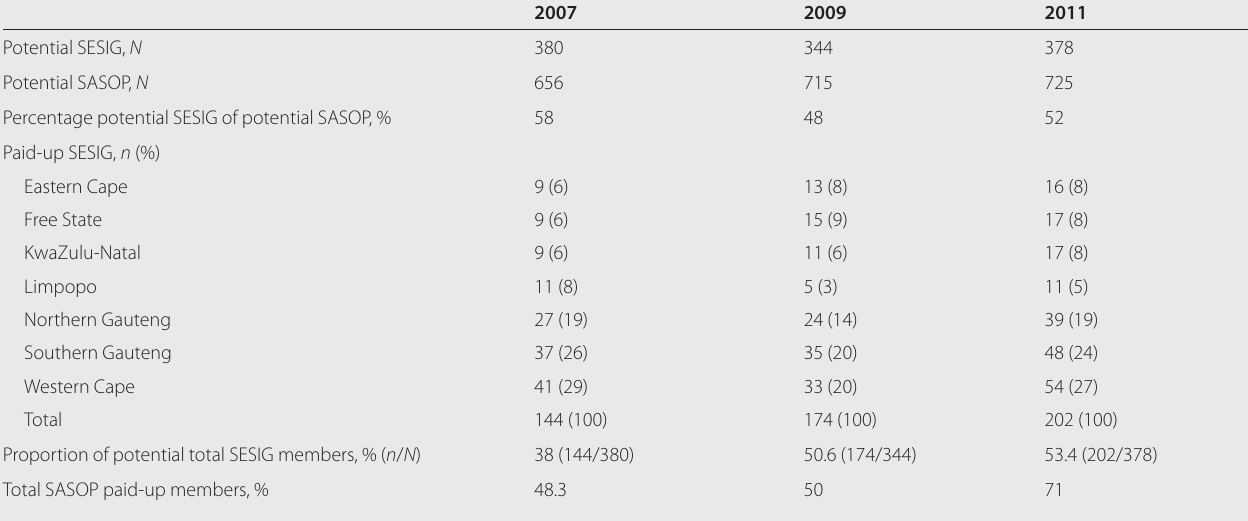
Table 1. Percentage of potential number of state-employed psychiatrists as paid-up SESIG